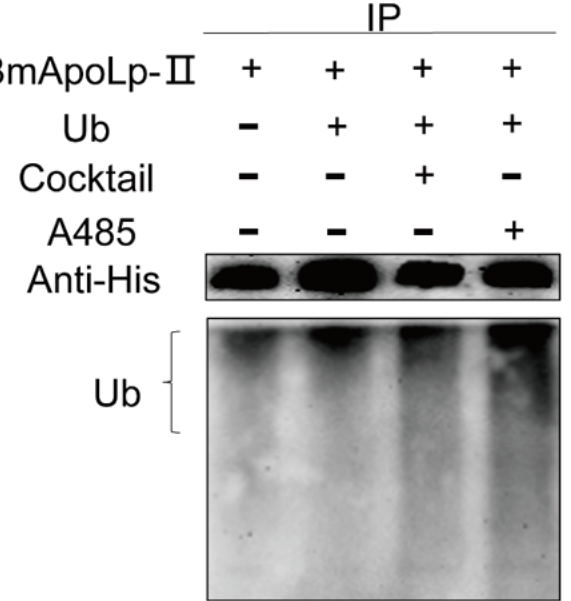
Figure 6. Acetylation could compete for ubiquitination to stabilize BmApoLp-II protein. The acetylation of the BmApoLp-II can compete for its ubiquitination modification. pIEX-1-s-GFP- BmApoLp-II and pIEX-1-si-Ub were co-transfected into BmN cells. After using cocktail to increase the acetylation level of BmApoLp-II, its ubiquitination level decreased, whereas using A485 to decrease the acetylation level of BmApoLp-II increased its ubiquitination level. “+” means existence, “-” means no existence.